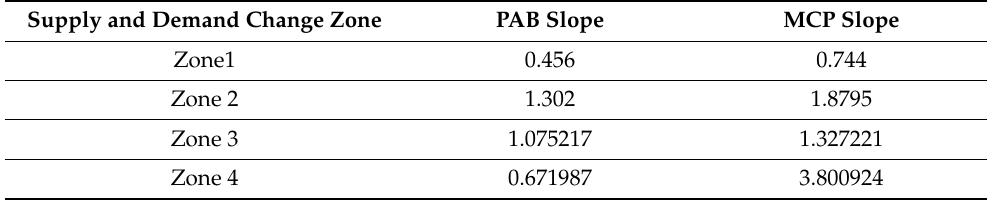
( b ) Figure 8. Benefits of frequency regulation units when PAB ( a ) and MCP ( b ) are adopted in Si- chuan. We can see by looking at the compensation formula that the main factors determining the amount of frequency regulation benefits, in addition to price, include performance indicators, the winning capacity and frequency regulation mileage. In addition, the